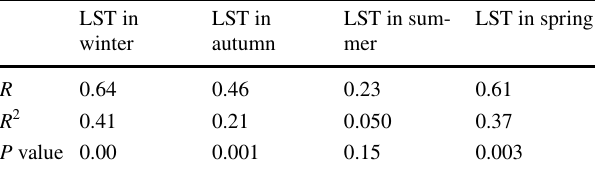
Table 4 Correlation between LST and methane in different months in